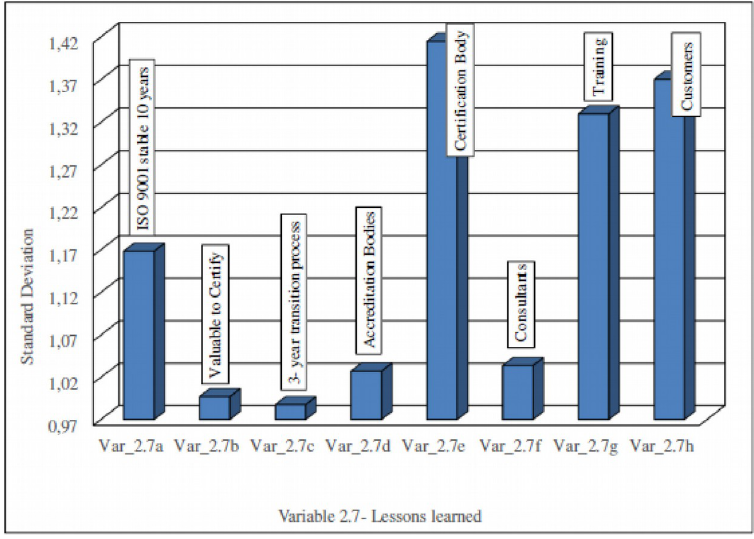
Figure 6. Standard deviation of the lessons learned with the implementation of the ISO 9001:2015 transition/certification